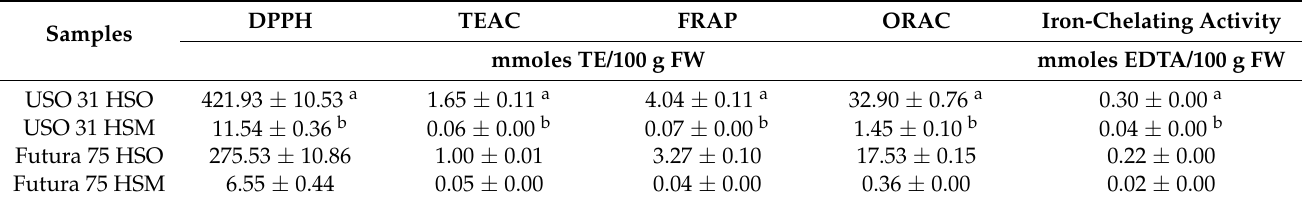
Table 7. Antioxidant and free-radical scavenging properties of USO 31 and Futura 75 hempseeds oil (HSO) and their processing byproducts (hempseed meal, HSM). Data, which are the mean ± standard deviations (SD) of three independent experiments ( n = 3), were expressed as mmoles of trolox or ethylenediaminetetraacetic acid equivalents (TE and EDTA, respectively)/100 g of fresh weight